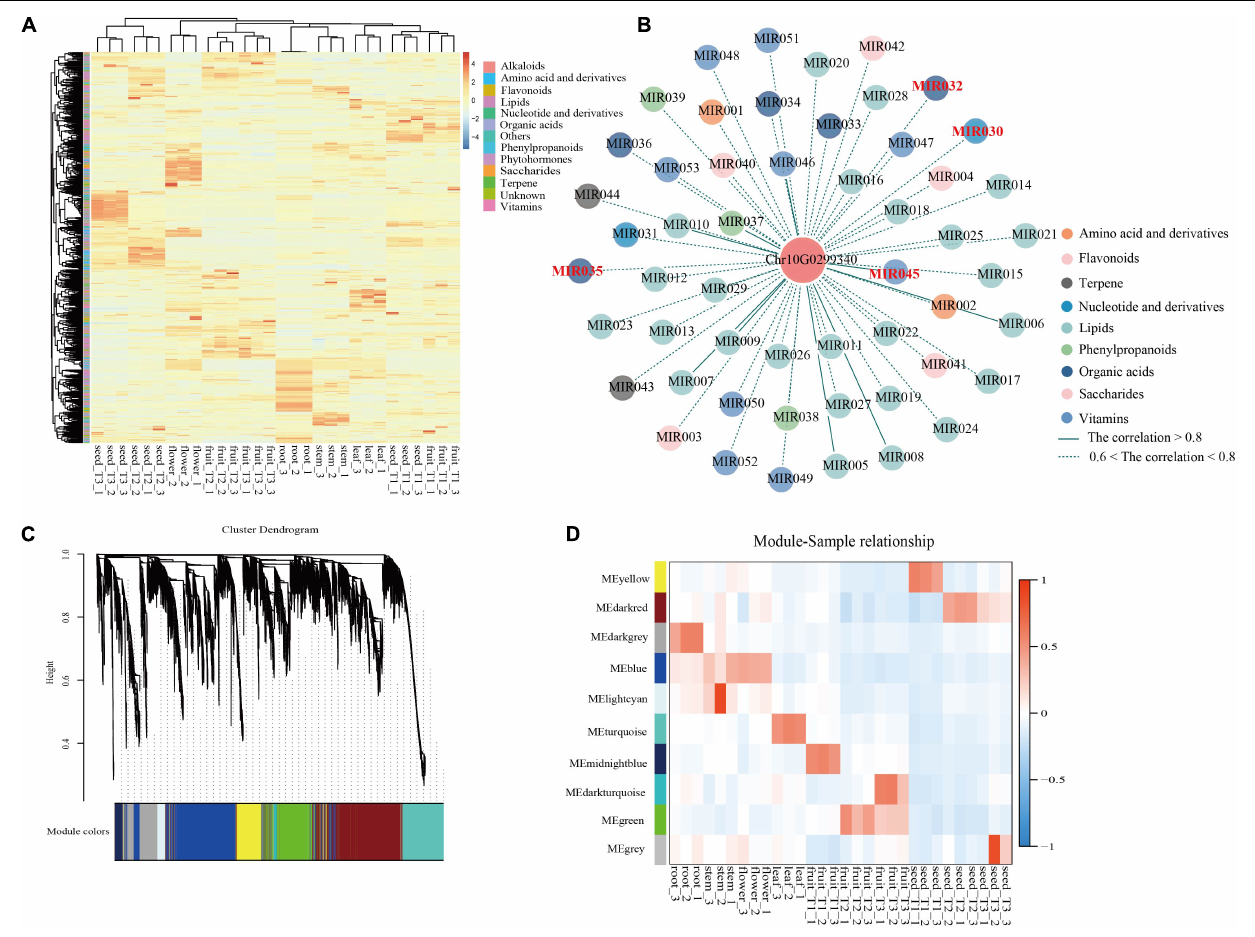
FIGURE 6 | Integrated analysis of metabolome and transcriptome revealed the functions of miraculin in S. dulcificum . (A) Heatmap of metabolites detected in six tissues including fleshes and seeds from three stages of S. dulcificum fruits. (B) Regulatory network of metabolites highly related to miraculin. (C) The dendrogram of co-expression modules identified by WGCNA across samples. (D) The heatmap of the correlation between samples and modules. [MIR030, inosine 5 (cid:48) -monophosphate; MIR032, citric acid; MIR035, urate; MIR045, pyridoxine (vitamin B6)].